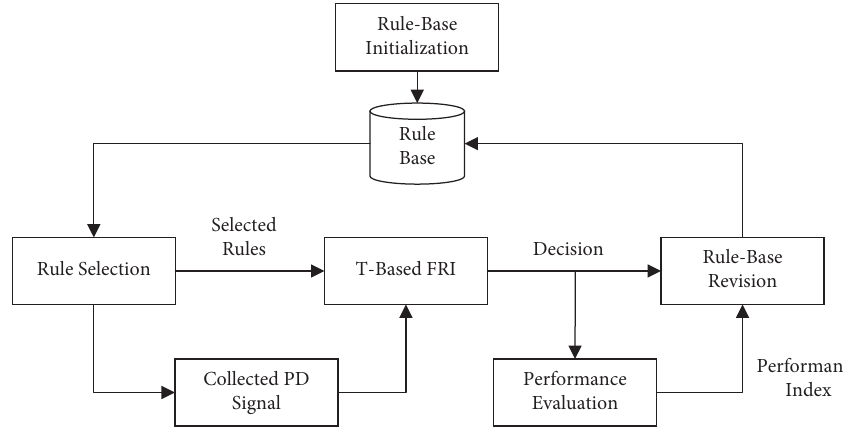
Figure 1: The framework of fuzzy interpolation inference for PD UHF